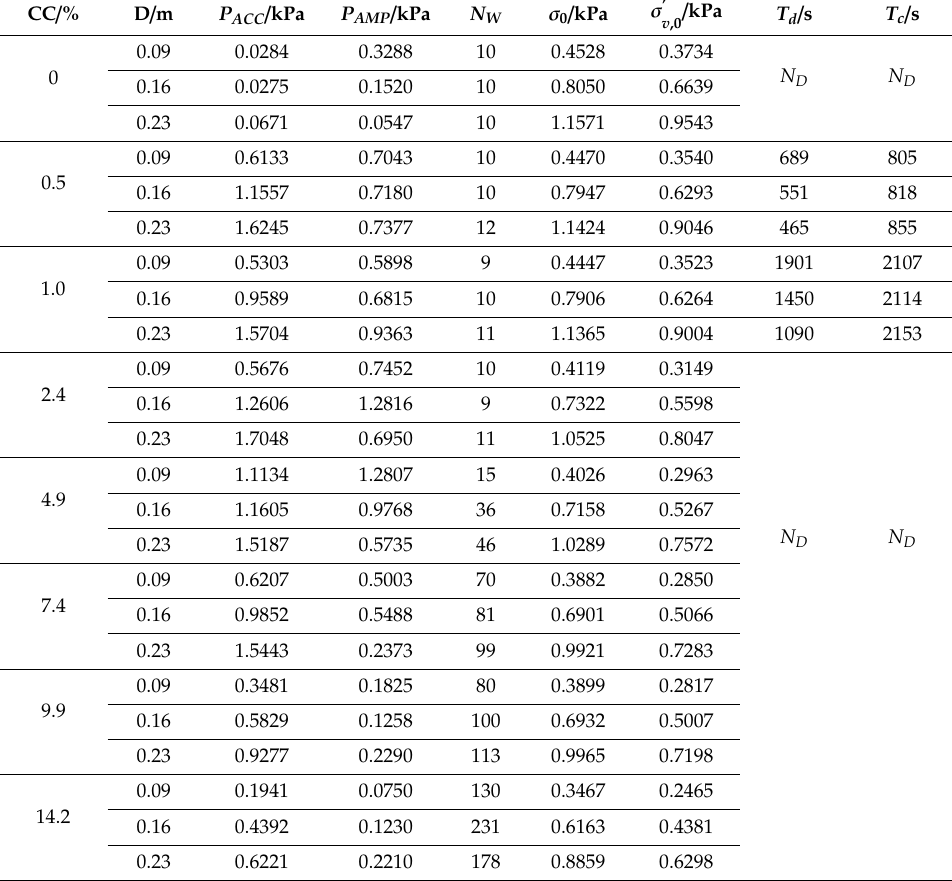
Table 3. Seabed responds under wave